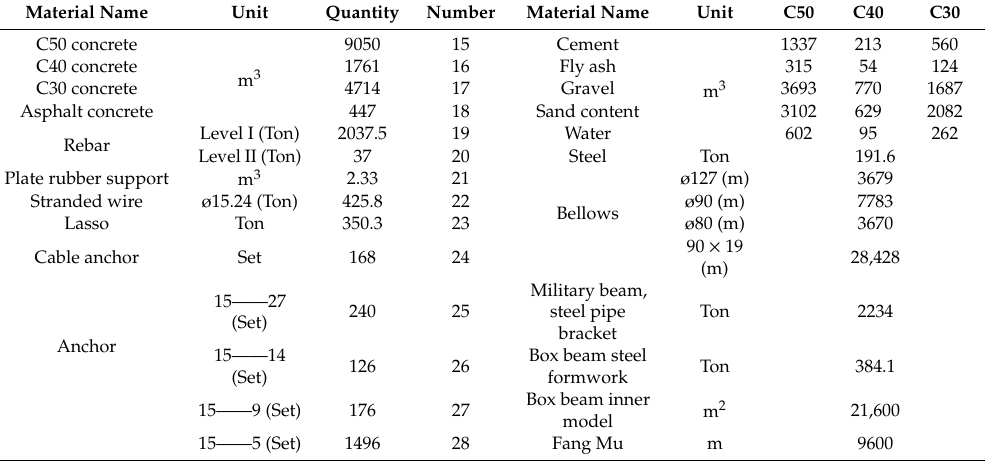
Table 6. Statistical table of raw materials and accessory materials of the cable-stayed